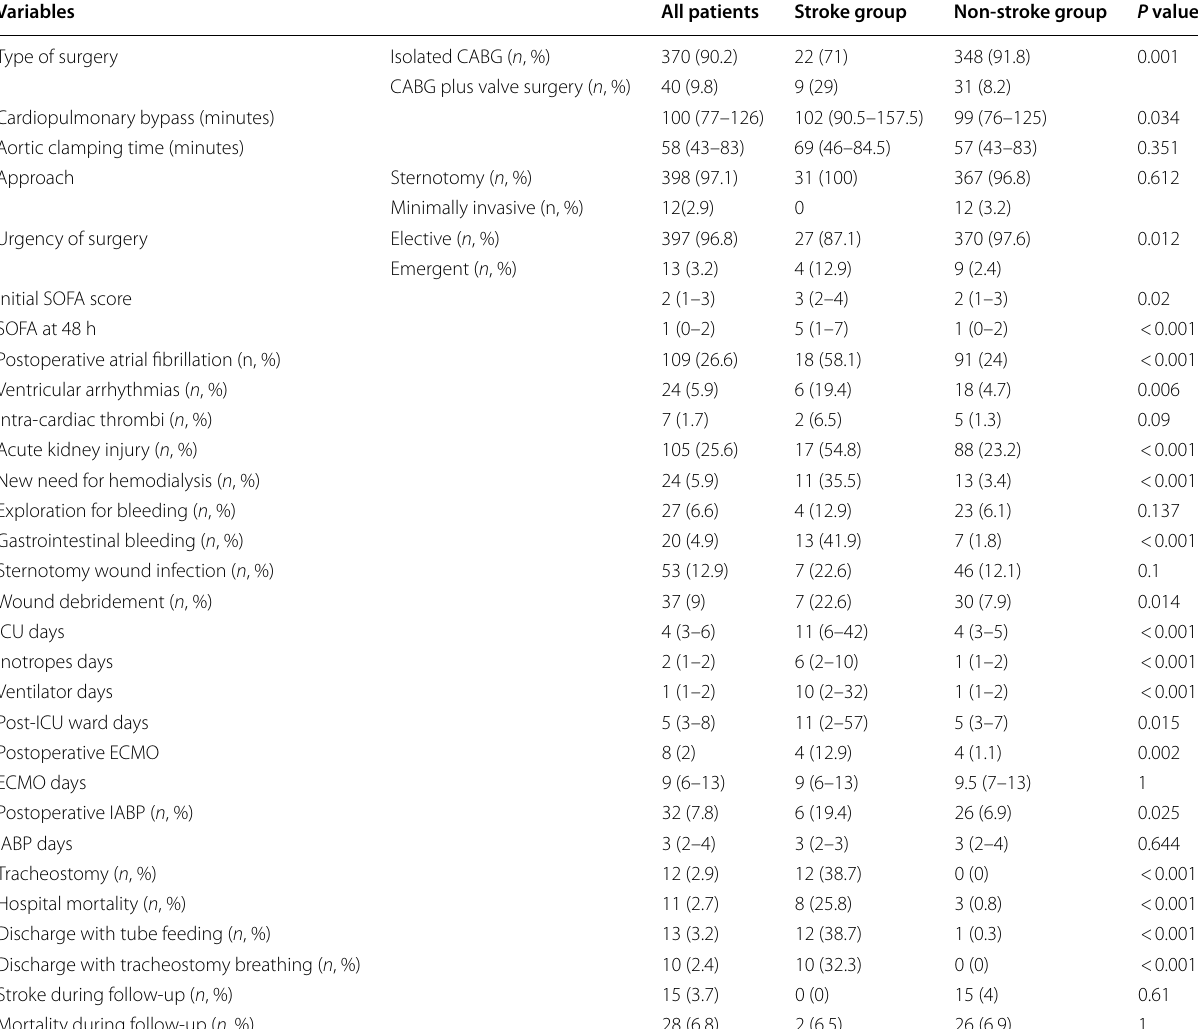
Table 3 Perioperative variables and outcomes Variables All